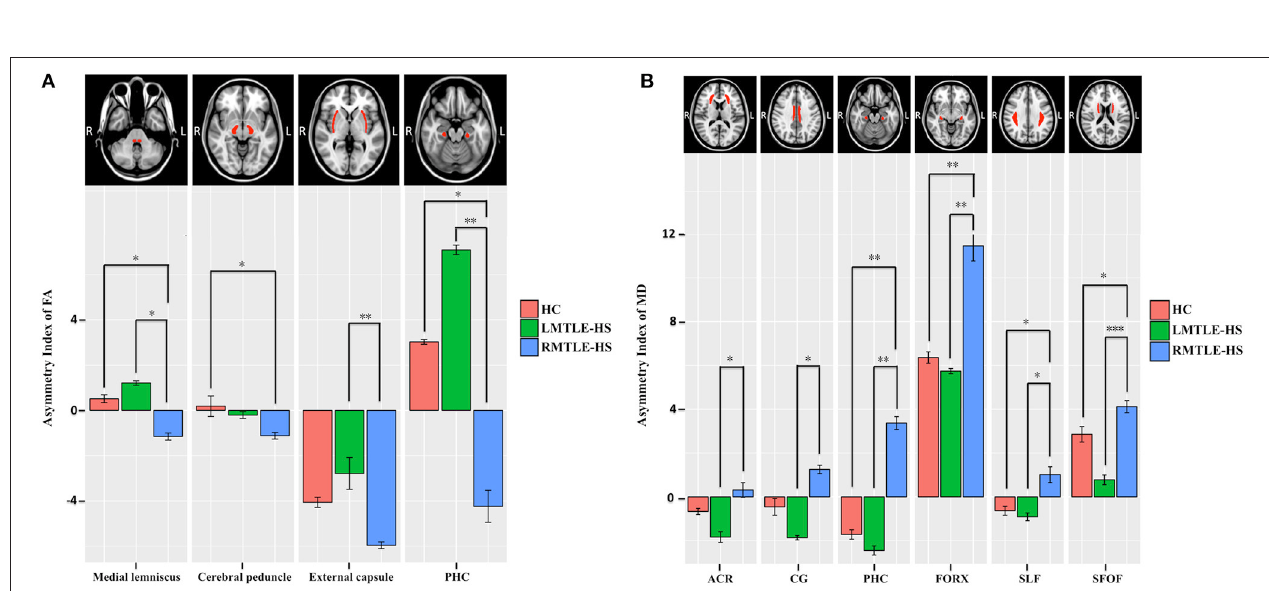
FIGURE 3 | The asymmetry index (AI) differences of the paired-ROIs in bilateral hemispheres among HC, LMTLE-HS, and RMTLE-HS. (A) Represents the AI of FA and (B) represents the AI of MD. Red represents FA or MD values in HC; green, patients with LMTLE-HS; blue, patients with RMTLE-HS (* P < 0.05; ** P < 0.01; *** P < 0.001). PHC, parahippocampal cingulum; ACR, anterior corona radiate; CG, cingulum fibers within the cingulate gyrus; FORX, fornix; SLF, superior longitudinal fasciculus; SFOF, superior fronto-occipital fasciculus.